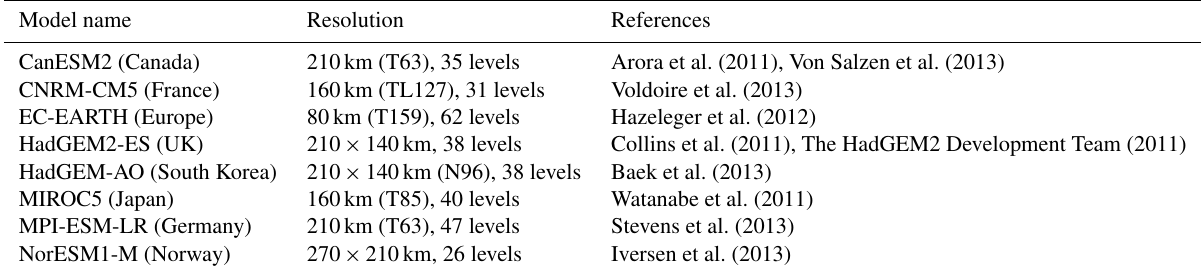
Table 2. List of the various CMIP5 GCMs that have been downscaled with COSMO-CLM for the CORDEX domains assessed in this study. Model